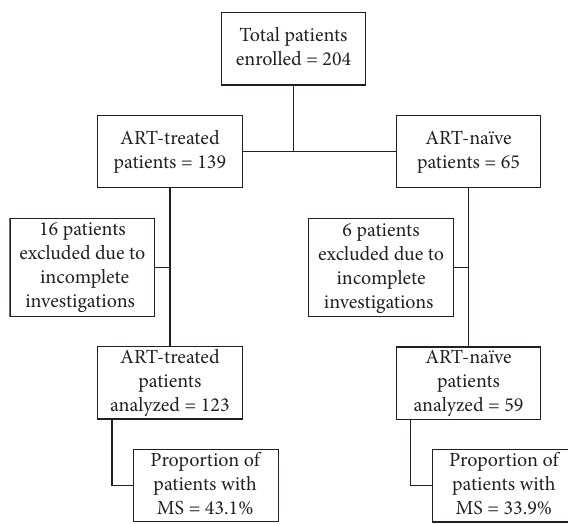
Figure 1: Flowchart showing recruitment of study participants. Table 1: Details of the study participants according to class of ART received ( n �